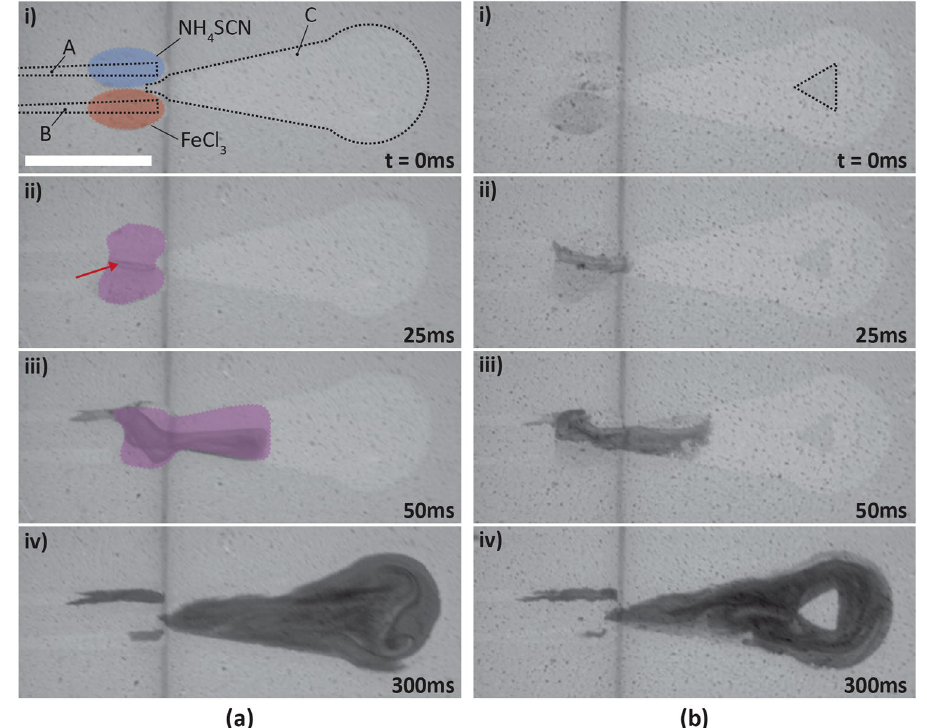
Figure 2. Mixing on two SDSM. ( a , b ) Timestamps displaying mixing of ~30 µ L of ammonium thiocyanate (Liquid 1 on track A) and ~40 µ L of ferric chloride (Liquid 2 on track 2) solutions on ( a ) a SDSM without a superhydrophobic island (control case), and ( b ) an identical SDSM with a triangular superhydrophobic island (outlined with a dotted-line in ( b - i )).(i) Liquid bulges are formed as the two liquids accumulate at the wide ends of the A and B tracks; (ii) a liquid bridge is formed over the C wedge extension (mixing layer shown by red arrow); (iii) the solutions mix and are driven pumplessly to the right into the C Wedge area; (iv) further mixing is accomplished with advective transport along C wedge and around the superhydrophobic island (if present). The scale bar in the lower left corner of ( a - i ) denotes 1 cm and applies to all images in ( a ) and ( b ). The transparent red and blue ovals in ( a - i ), and the transparent purple shapes in ( a - ii , a - iii ) have been overlaid onto the images for demonstration purposes, to demarcate the boundary of the liquid bulge. In addition, the grey vertical streaks in all frames are markings on the underlying supporting platform used to align the SDSM during imaging, and had no influence on the mixing